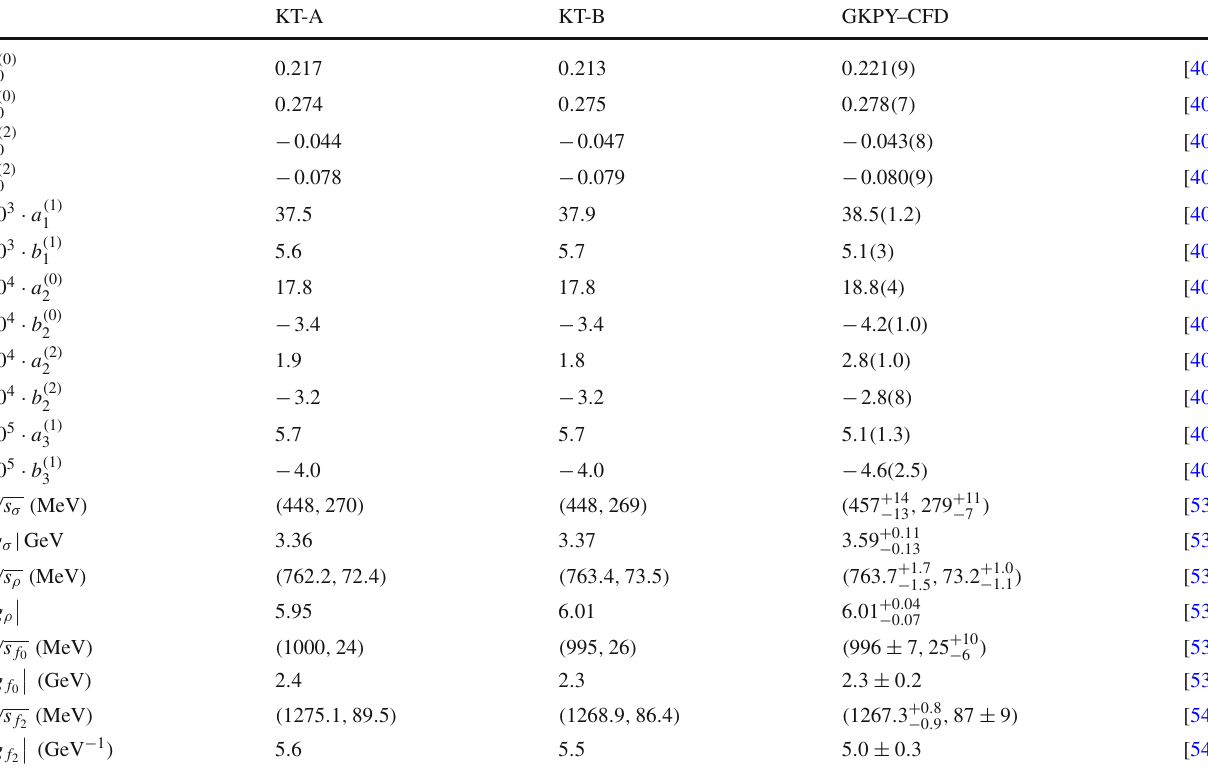
Table 1 Threshold parameters and the pole positions and couplings for the σ , ρ , f 0 ( 980 ) , and f 2 ( 1270 ) (the latter two are simply denoted abovesimplyas f 0 and f 2 ,respectively)obtainedwiththeKTequations (second and third columns for setups A and B, respectively) are shown.